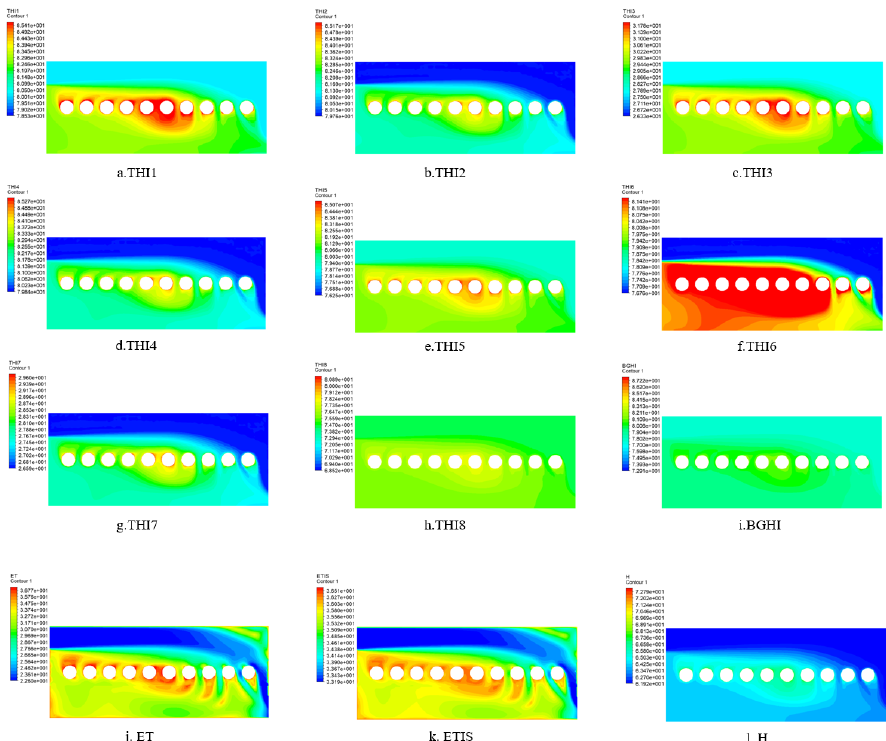
Figure 5. The distribution of various heat indices in the cross section of the pig barn. THI is the temperature and humidity index. The numbers 1-8 after THI represent different forms of THI, which are shown in Table 1. BGHI is black globe-humidity index. ET is effective temperature. ETIS is equivalent temperature index of sows. H is enthalpy.